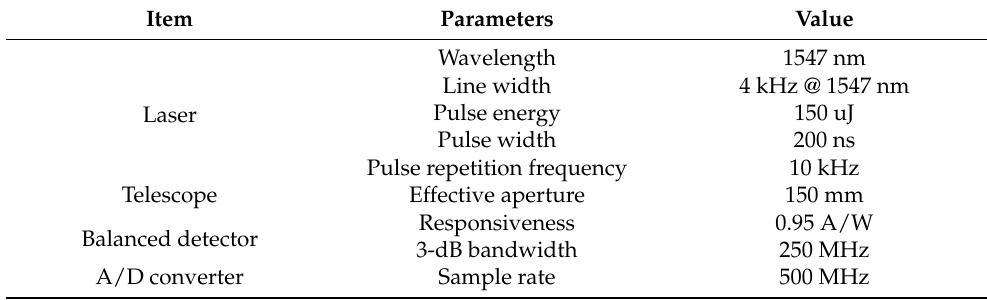
Figure 4. The CDWL in the field experiment. Table 3. Key parameters of the